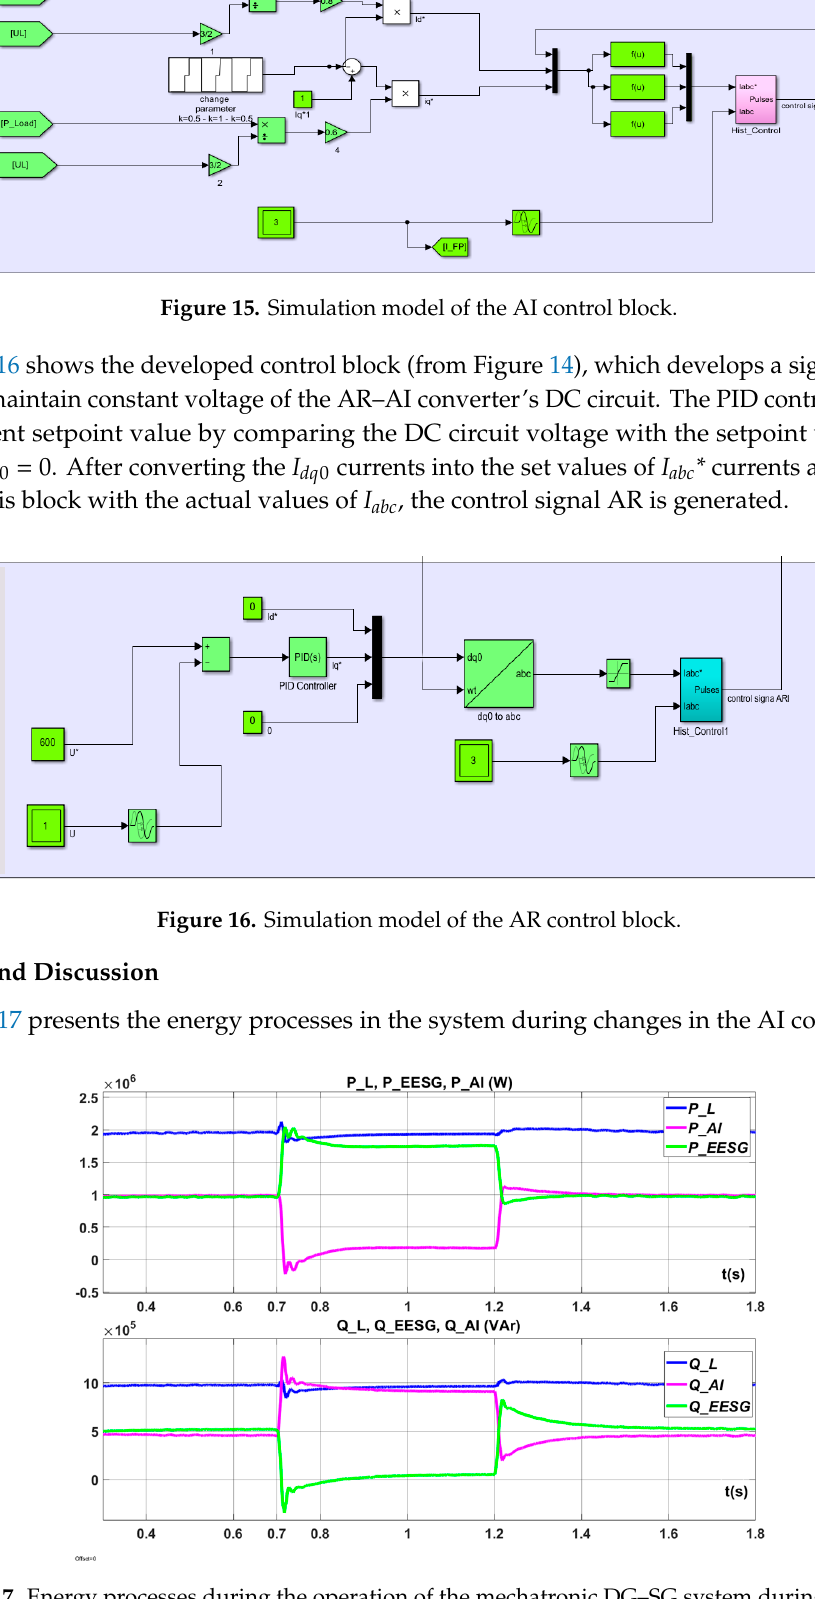
Figure 17. Energy processes during the operation of the mechatronic DG–SG system during a change from k = 0.5 to k = 1 (“cleaning” of the diesel engine of the DG set) and then back to k = 0.5.